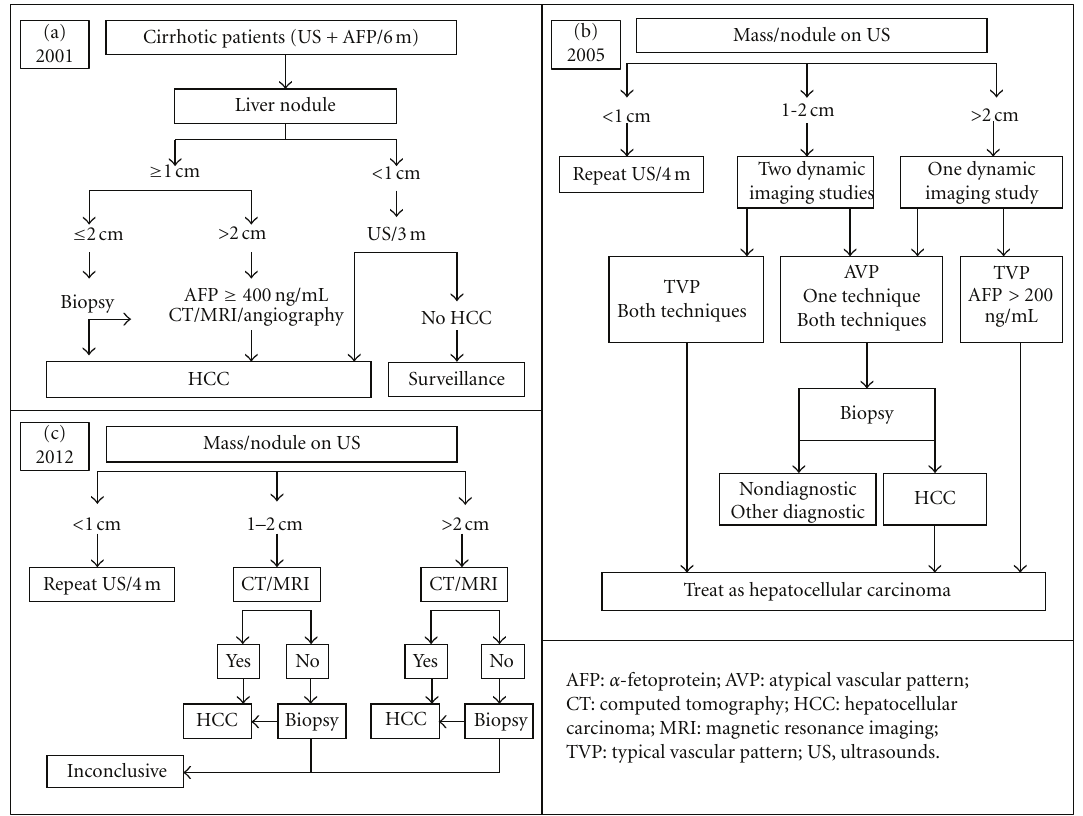
Figure 1: Development of di ff erent European and US flow charts proposed in the last decade for the diagnosis of HCC. AFP has progressively disappeared from the variables used for the diagnosis. Flow-chart (a): from Bruix et al. EASL guidelines 2001 [2], with modifications; flow chart (b): from Bruix et al. AASLD guidelines 2005 [3], with modifications; flow-chart (c): from EASL-EORTC guidelines 2012 [4], with